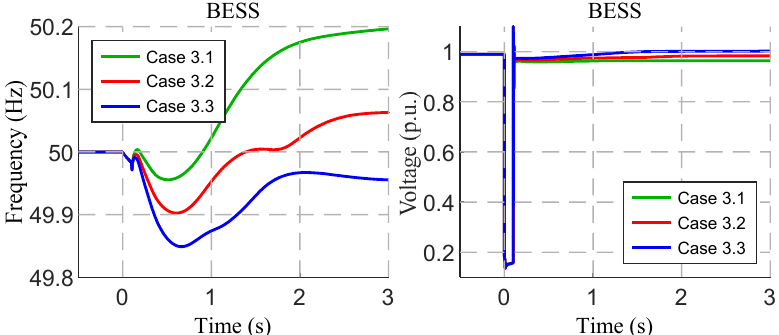
Figure 20. BESS power converter synthetic frequency and terminal voltage regarding different shapes of the CI-RES voltage/reactive current hysteresis tuning.